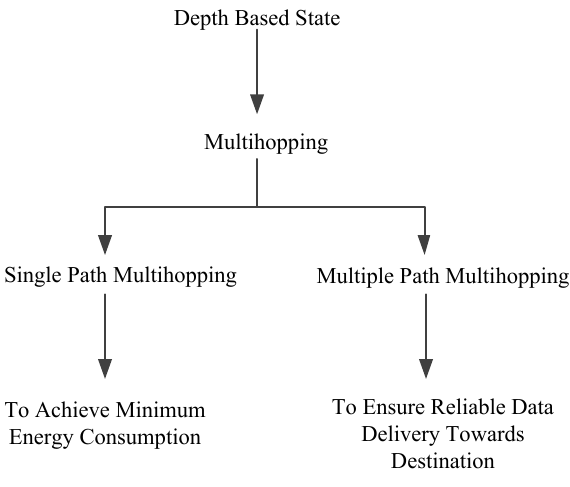
Figure 1. Pictorial Description of Depth-Based